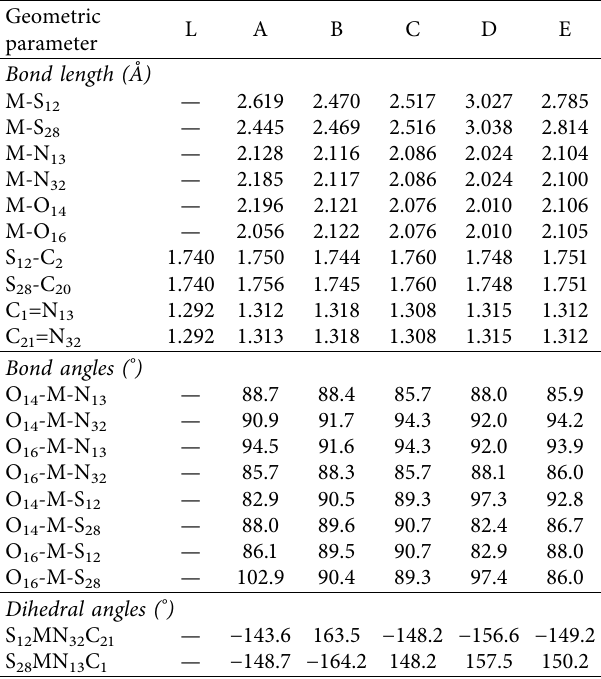
Table 1: Gas-phase optimized geometric parameters of molecules studied at BP86/def2-TZVP level of theory.